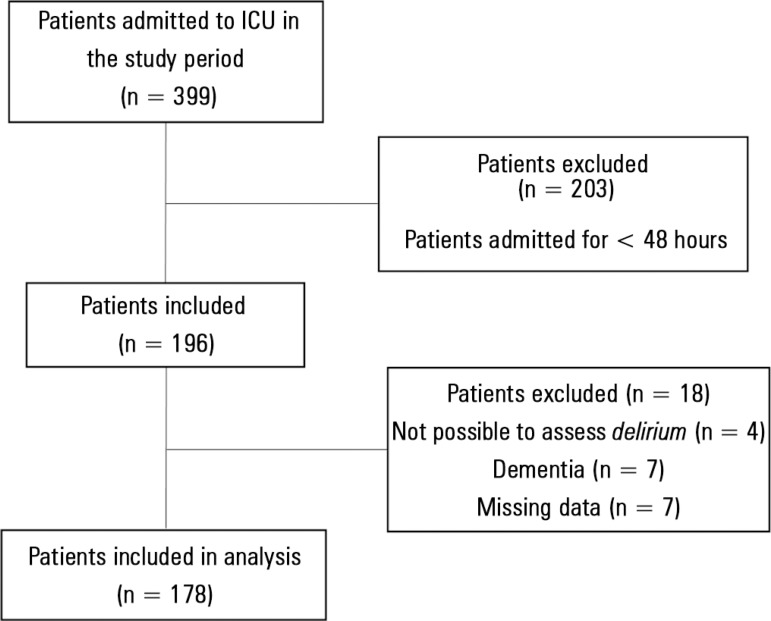
Flow diagram of patient inclusion.